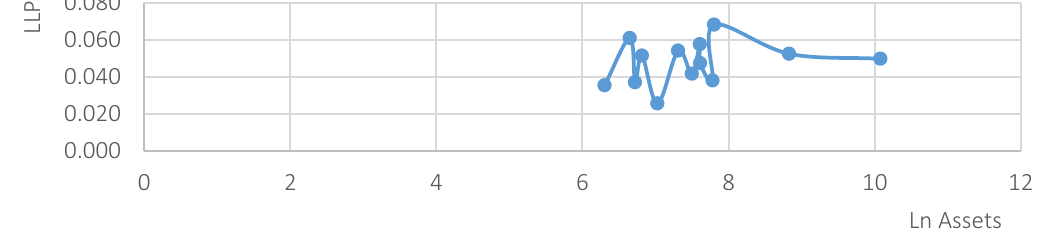
Figure 1. Bank size (Ln assets) and credit risk (LLP)